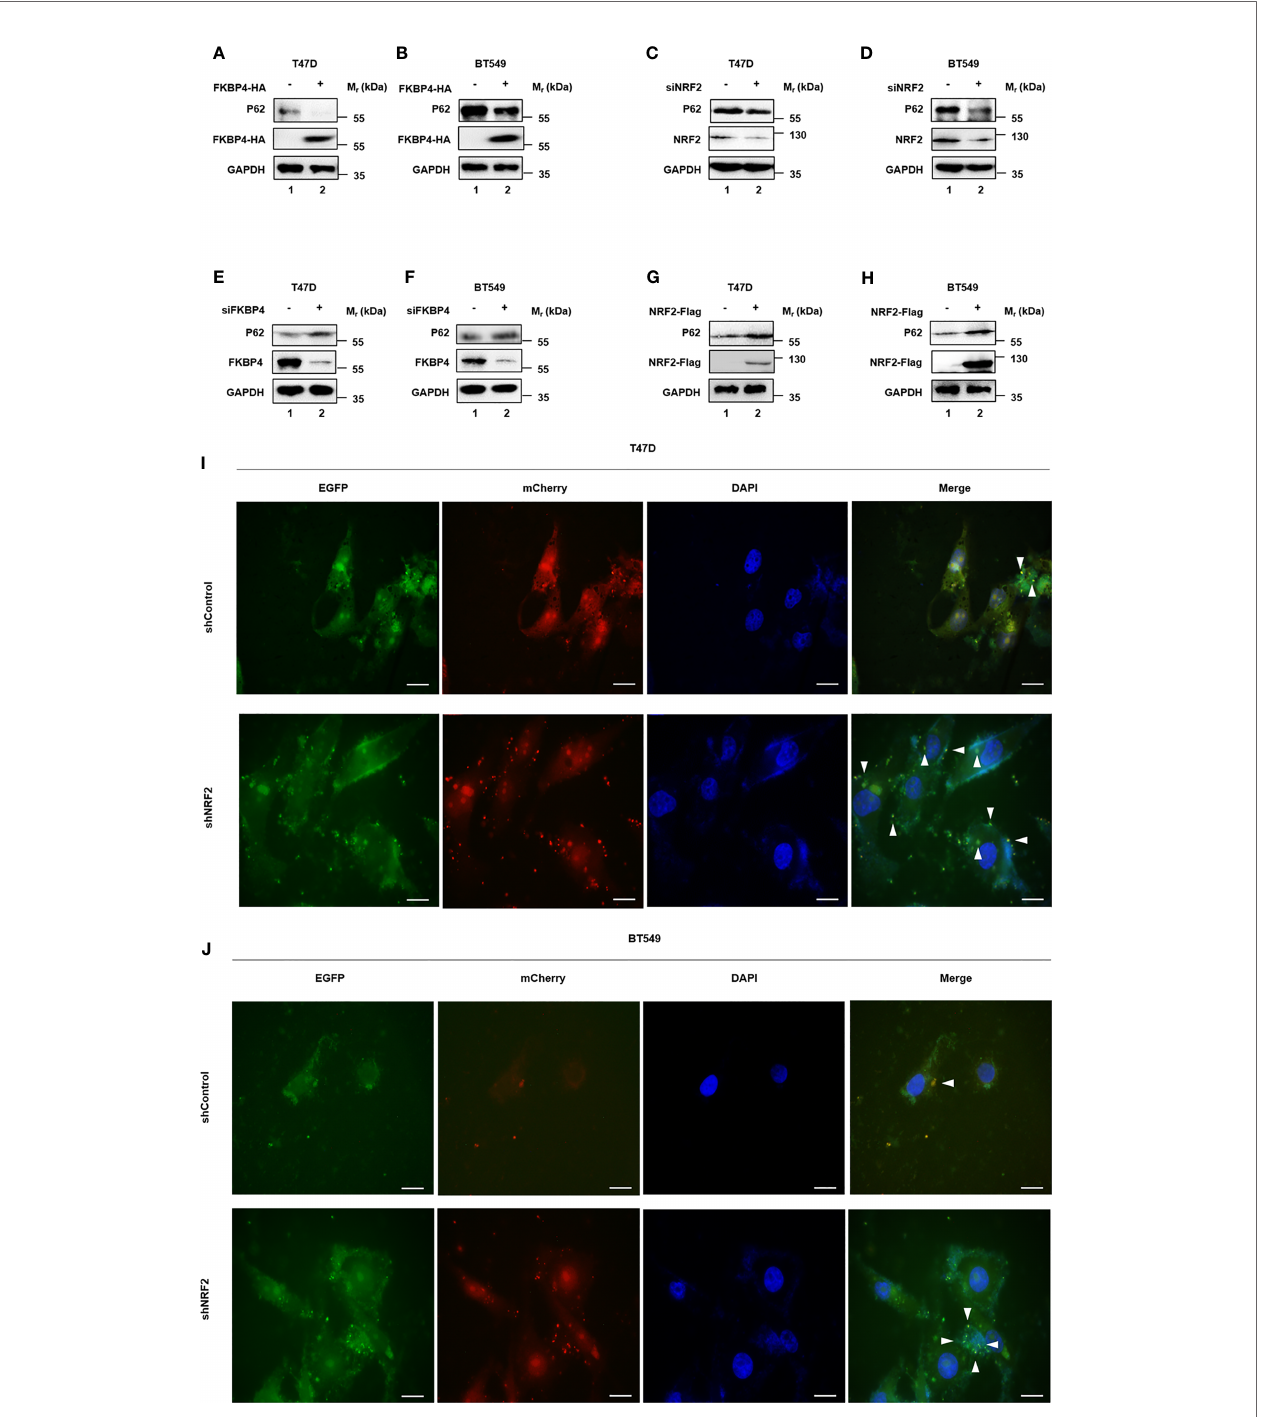
FIGURE 4 | FKBP4/NR3C1/NRF2 axis is involved in naringenin-restrained autophagy. (A, B) Representative western blot analysis results of P62, FKBP4-HA, and endogenous control GAPDH. Western blot analysis showed overexpressing FKBP4 resulted in downregulation of P62 in T47D and BT549 cells. (C, D) Representative western blot analysis results of P62, NRF2, and endogenous control GAPDH. Western blot analysis showed silencing NRF2 resulted in downregulation of P62 in T47D and BT549 cells. (E, F) Representative western blot analysis results of P62, FKBP4, and endogenous control GAPDH. Western blot analysis showed silencing FKBP4 resulted in upregulation of P62 in T47D and BT549 cells. (G, H) Representative western blot analysis results of P62, NRF2-Flag, and endogenous control GAPDH. Western blot analysis showed overexpressing NRF2 resulted in upregulation of P62 in T47D and BT549 cells. (I, J) Measurement of autophagy fl ux in T47D